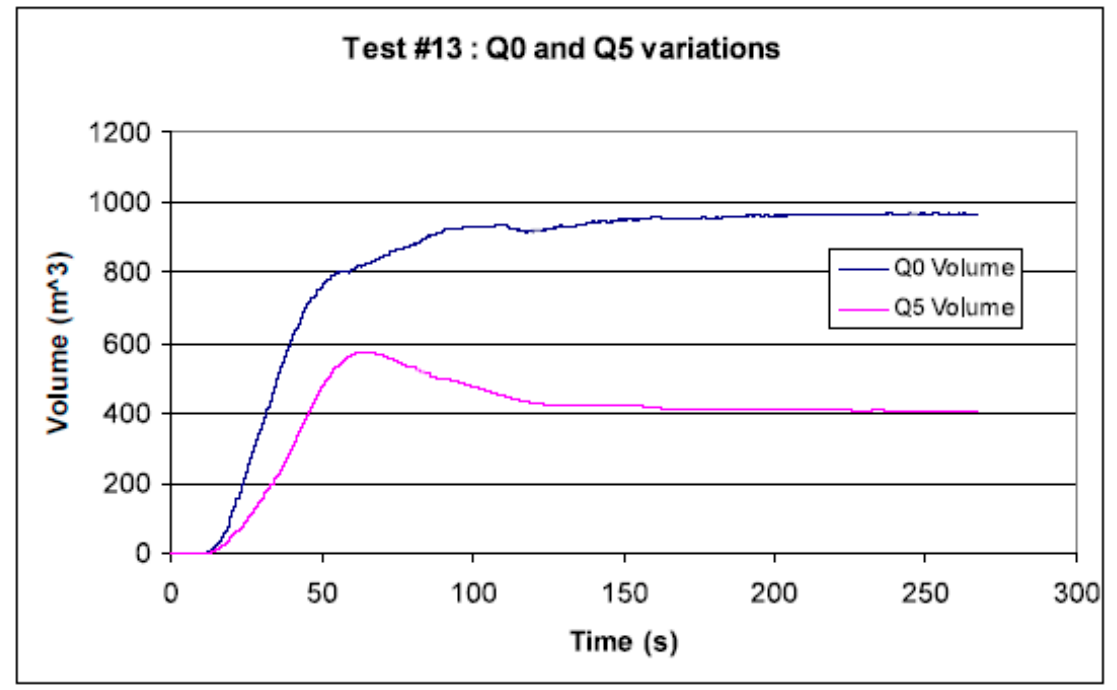
Figure 12. Calculated evolution of ESC volumes from experimental data for two ESC models: Q0 and Q5. This shows the sensitivity of the ESC model on maximum flammable cloud volumes and their evolution with time (taken from [17]).